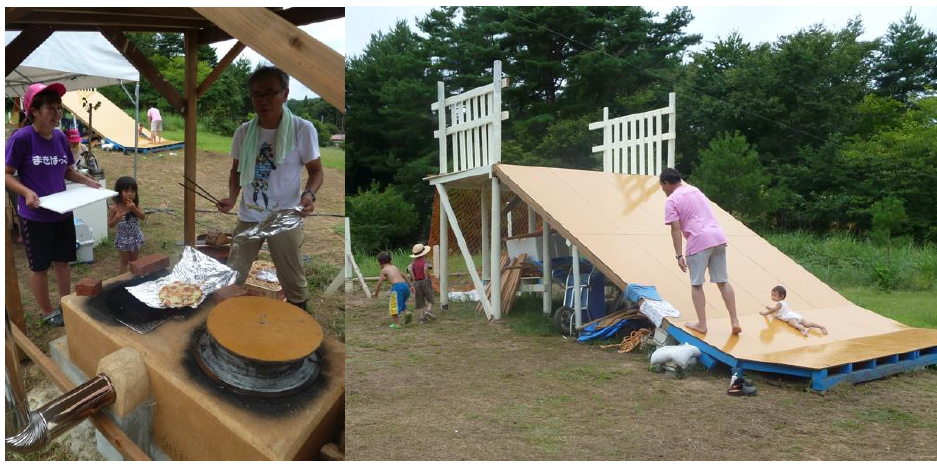
Figure 2. Adventure playground built by the village community